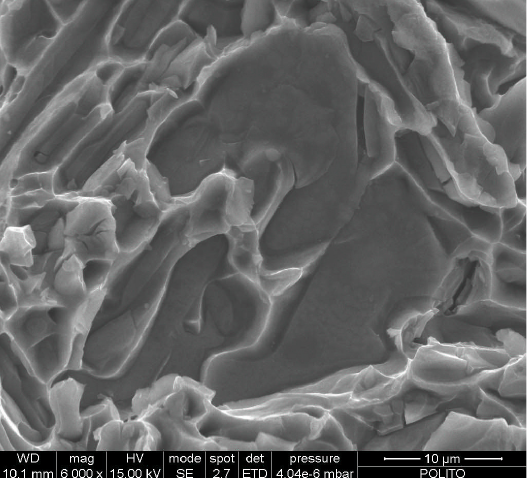
Figura 12: Ingrandimento della zona di frattura riportata in Fig. 4. Si noti che il campione è stato ruotato, rispetto alla visione di Fig. 4, Figure 12: Enlargement of the fracture area of Fig. 4. Please note that the specimen has been here rotated by a 180° angle around the axis normal to the overall rupture plane to achieve better light and